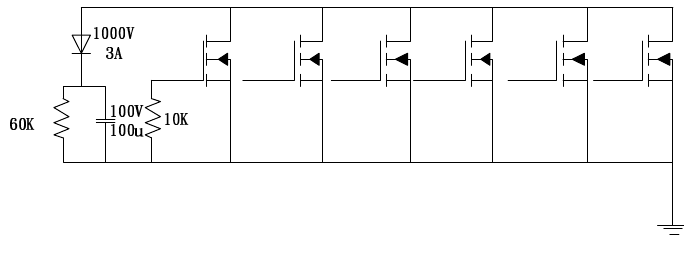
Figure 3. Schematic of the MOSFET switch in Figure 1.